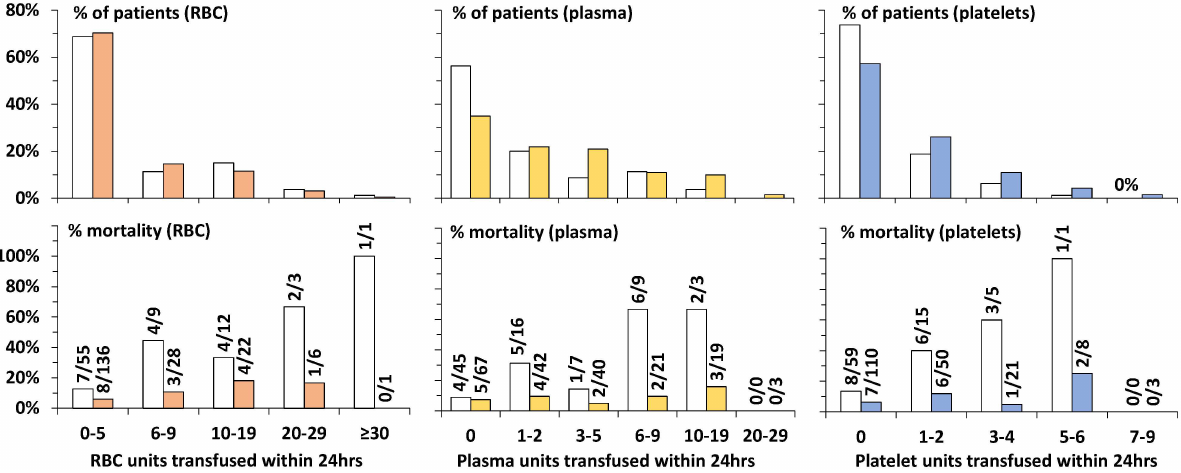
Fig 3. Transfusion and in-hospital survival per category of 24hr transfused blood products. MT indicatesmassive transfusion, RBC : red blood cells; plasma : frozen plasma; platelets :frozen platelets, LOS : length of stay. clear bars : pre-MTP, paddedbars : post-MTP, x/xx : deceased/total numberof